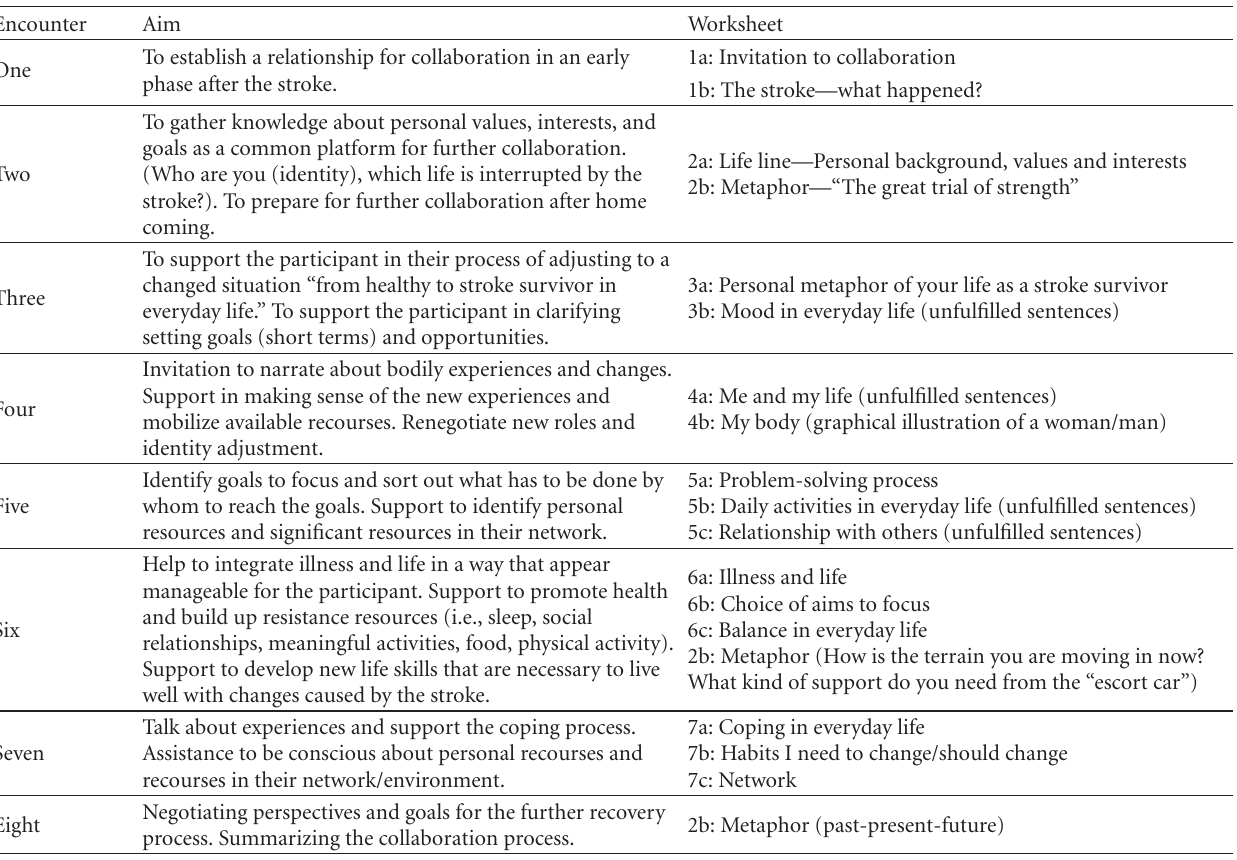
Table 1: Topical outline of the intervention (guiding